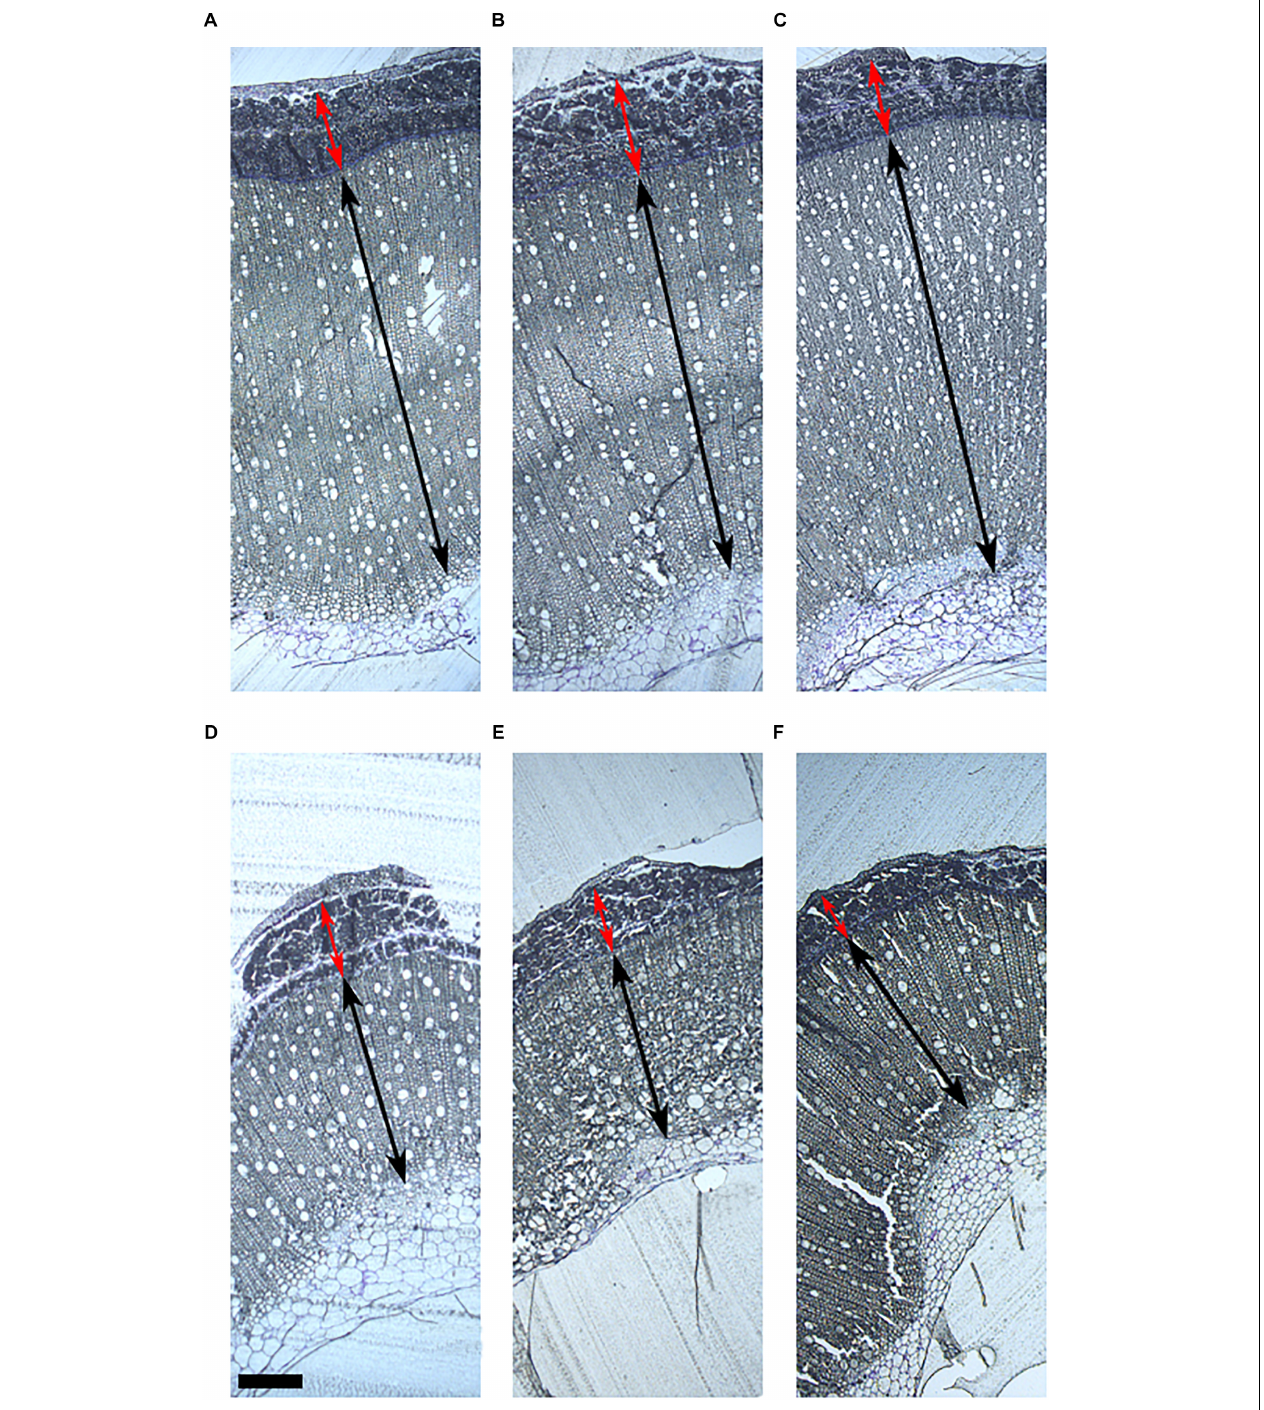
FIGURE 4 | Stem morphology of six contrasting hemp accessions. (A) CRA412, (B) FNPC243, (C) WU101, (D) CRA410, (E) CRA416, and (F) CRA420. Red arrows indicate the bast fiber, black arrows indicate the woody hemp core and scale bars are equivalent to 1000 µ